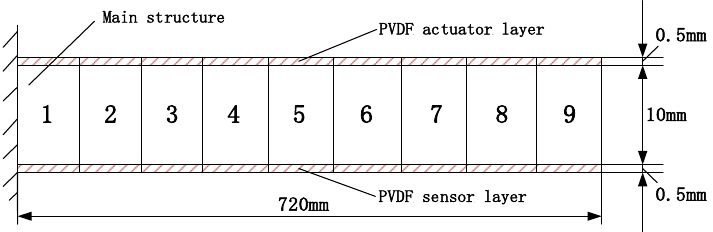
Figure 1. Composite cantilever beam structure.